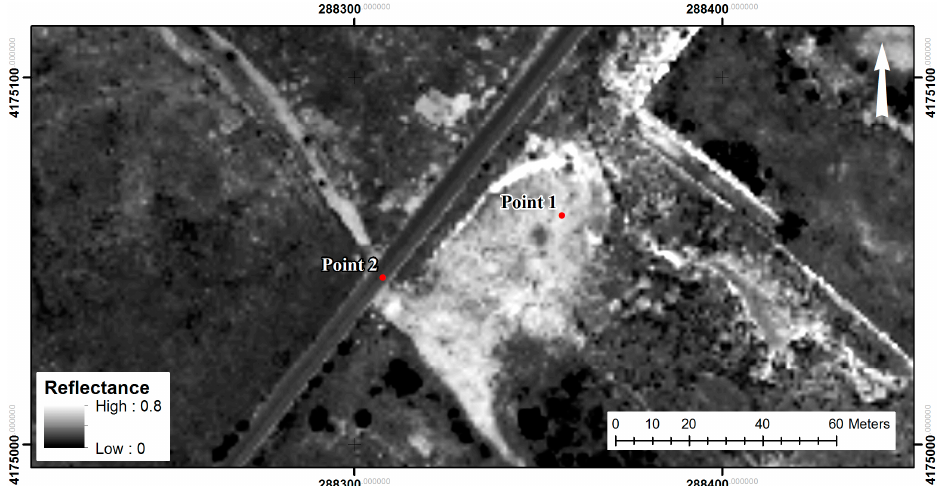
Figure 8. Calibrated reflectance map showing locations of spot comparisons. Point 1: Modern quarry strip. Point 2: Asphalt road. Visualization: 1 m spatial resolution raster calculated using the median value of each cell. Coordinate system: WGS84 UTM Zone 33N.